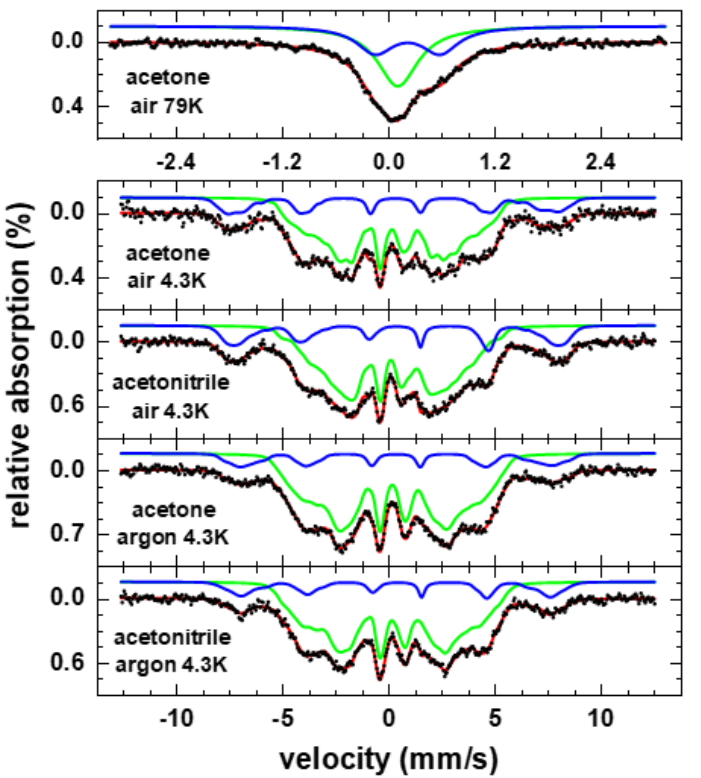
Figure 6. Mössbauer spectra of laser ablated FeRh nanoparticles in solution prepared under air/argon atmosphere in acetone or acetonitrile, respectively. Spectra were recorded at 4.3 K; subspectra can be assigned to metallic γ -phase FeRh (green) and an Fe 3+ -oxide phase (blue). A spectrum obtained at 79 K is shown for comparison on top.